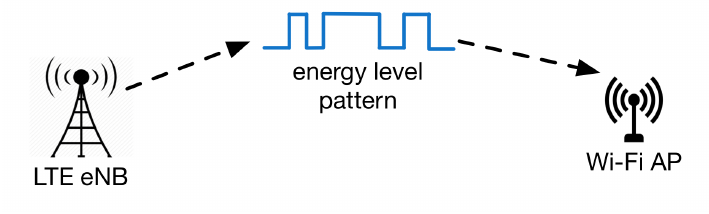
Figure 7. LTE identification via the predefined energy level